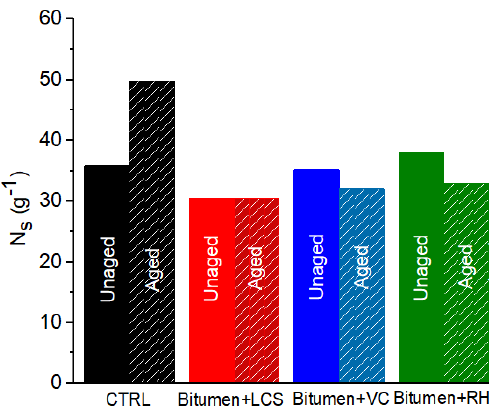
Figure 6. Spin density of asphaltene samples mixed with 2% w/w of antioxidants, as determined from the X-band EPR spectra registered at room temperature. CTRL indicates the control sample with no antioxidant added. Full bars: unaged samples; striped patterned bars: samples artificially aged through the Rolling Thin Film Oven Test (RTFOT) method.